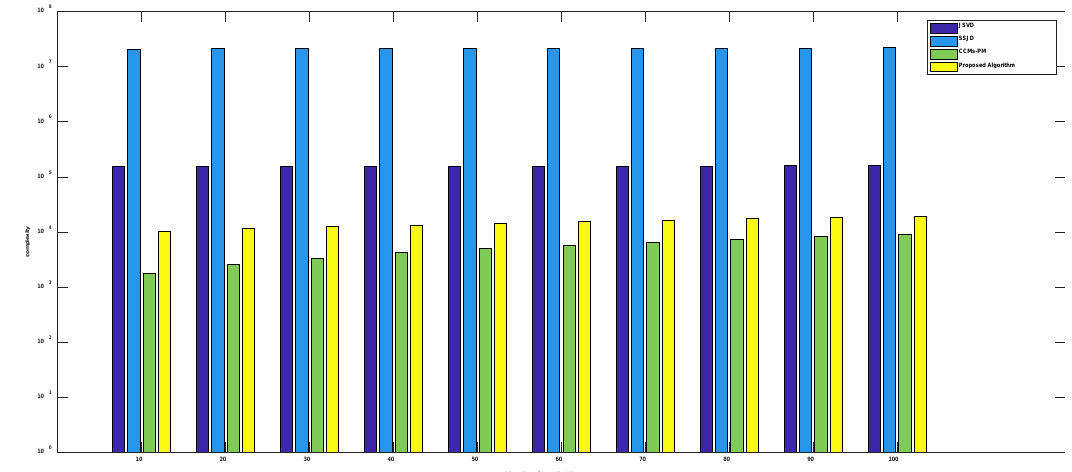
Figure 3. Comparison of complexity versus the number of sensors.